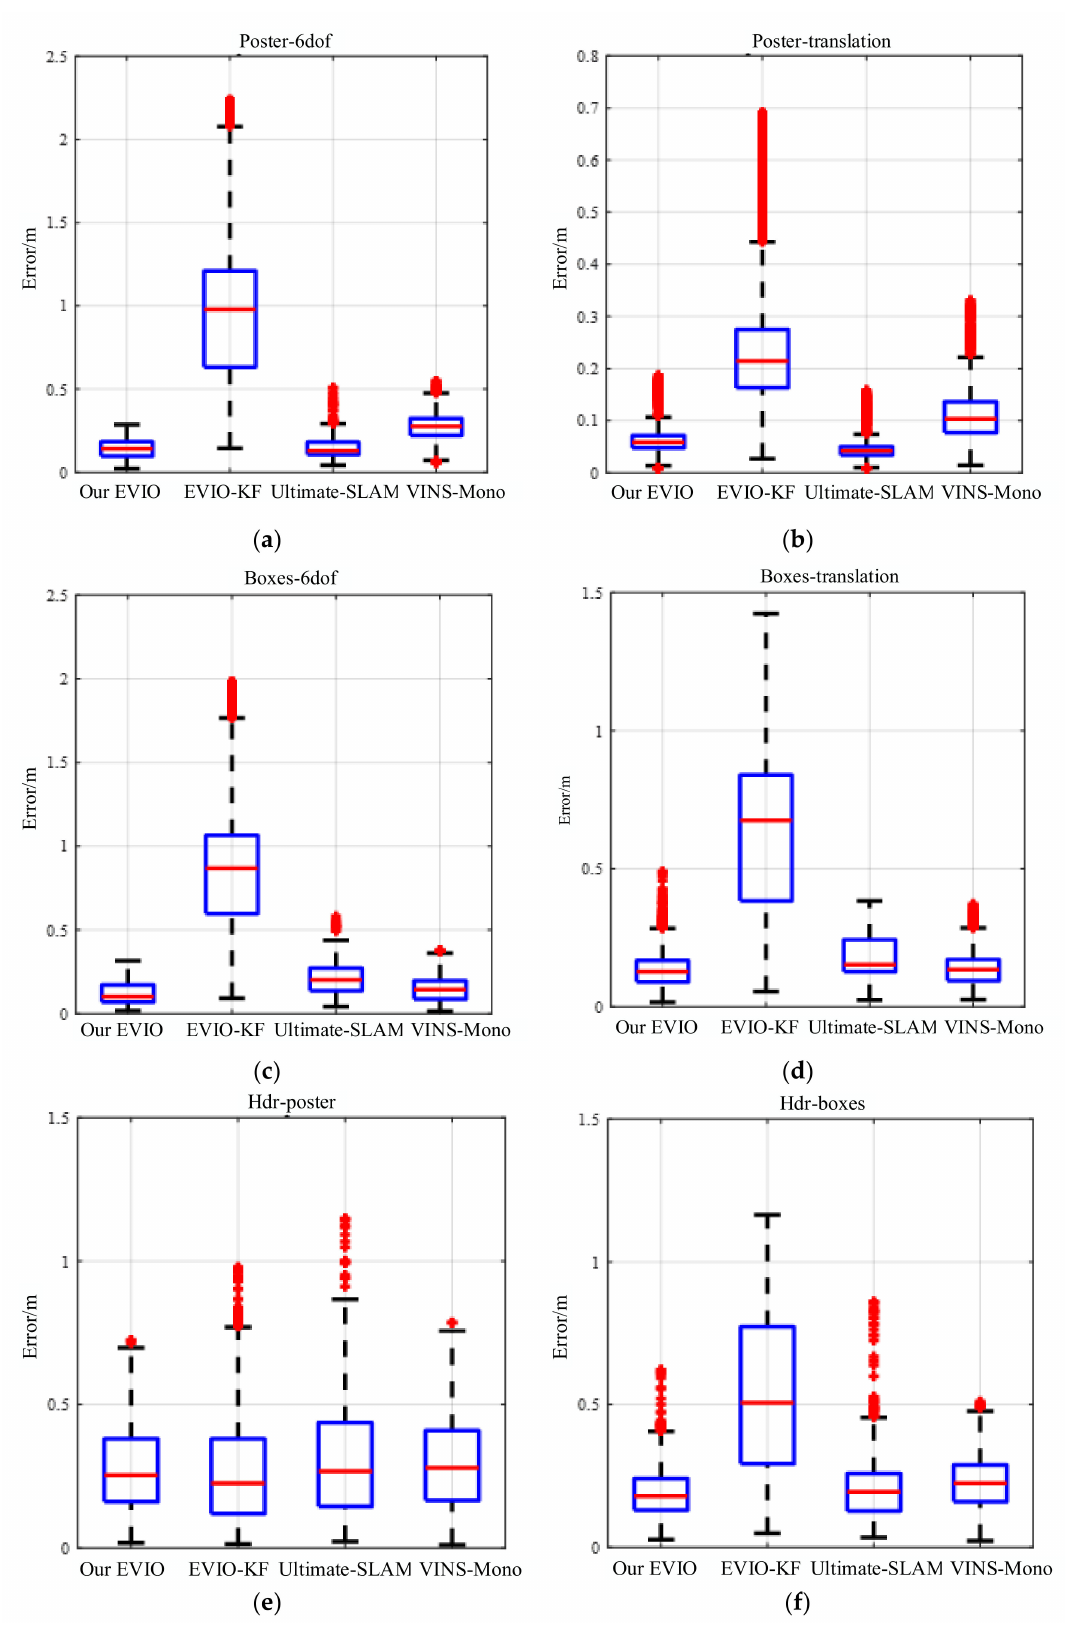
Figure 6. RMSE of proposed pipeline against others in Event Camera Dataset ( a ) poster_6dof; ( b ) poster_translation; ( c ) boxes_6dof; ( d ) boxes_translation; ( e ) hdr_poster; ( f )